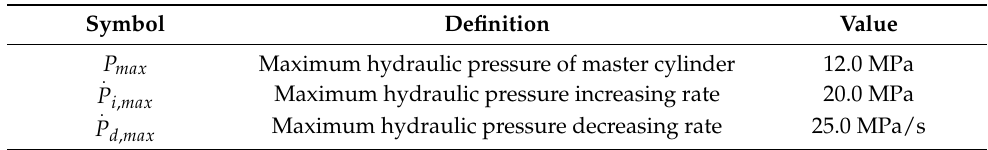
Table 1. Open-loop performance specifications of the EBMC in the